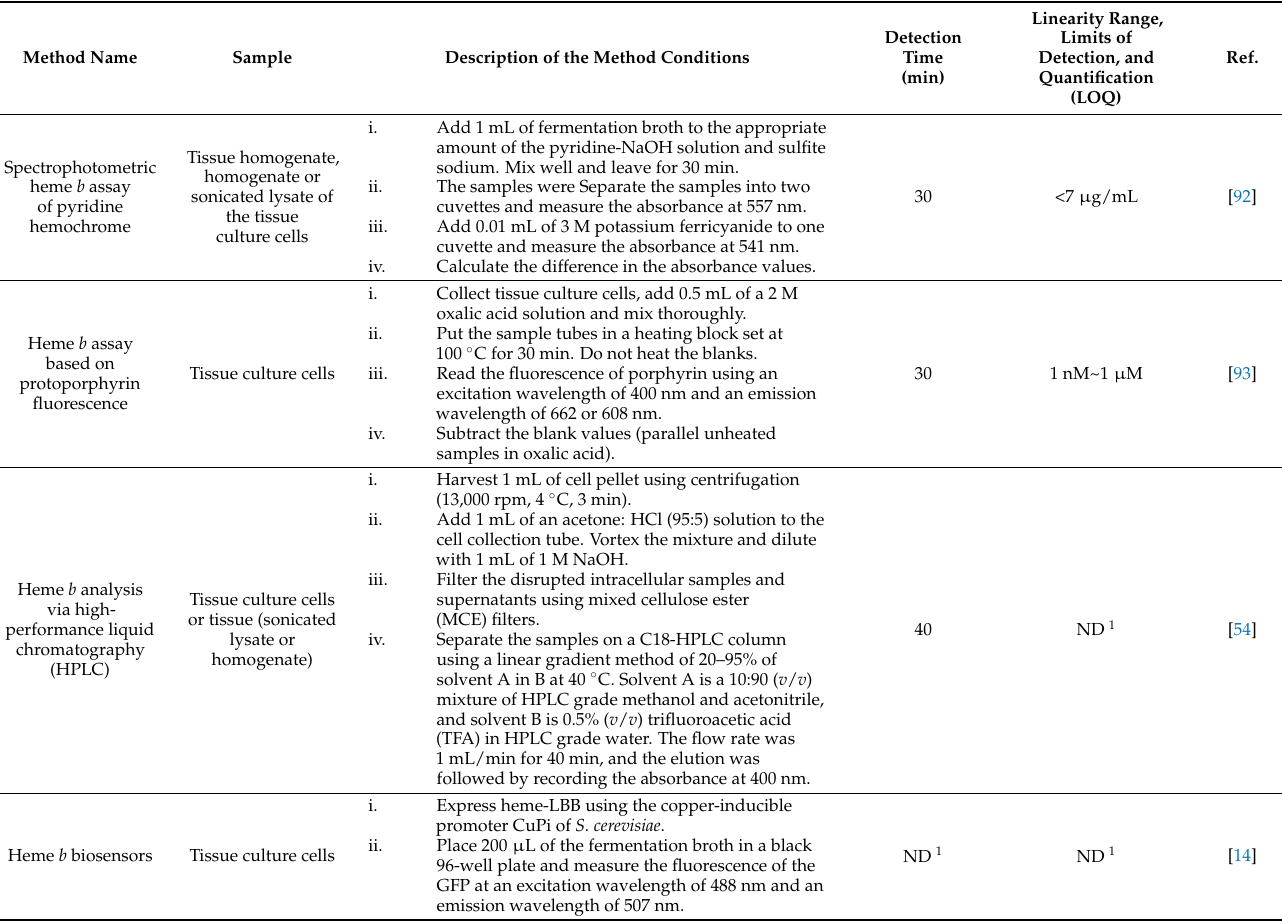
Table 2. Detection methods of heme b